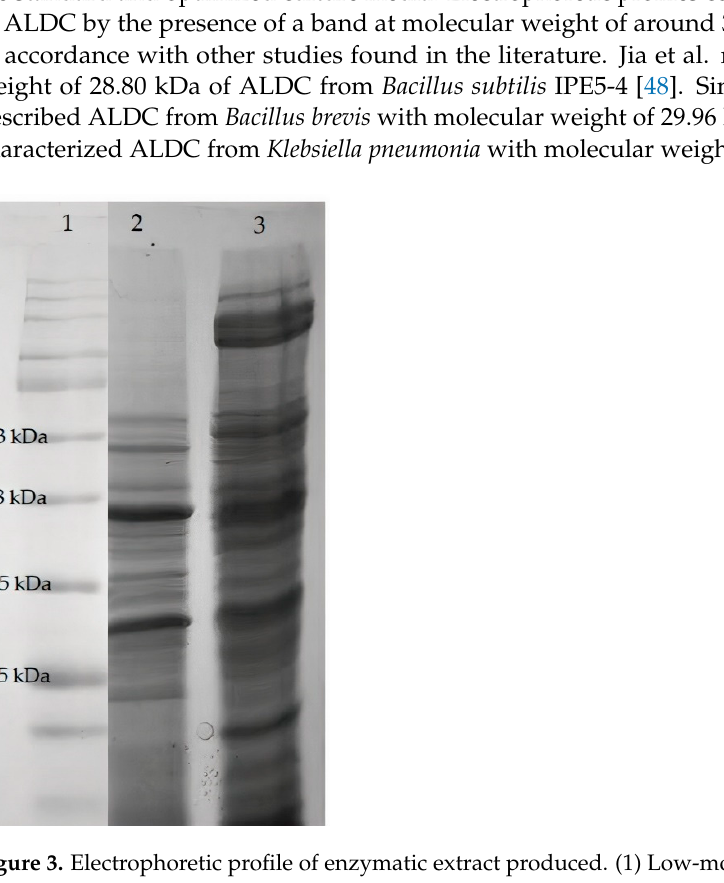
Figure 4. Effect of the temperature on ALDC activity at pH 6.0 (50 mM MES buffer). Results correspond to the average of triplicate experiments ± standard deviation. Relative activity is expressed as a ratio of the maximum activity.